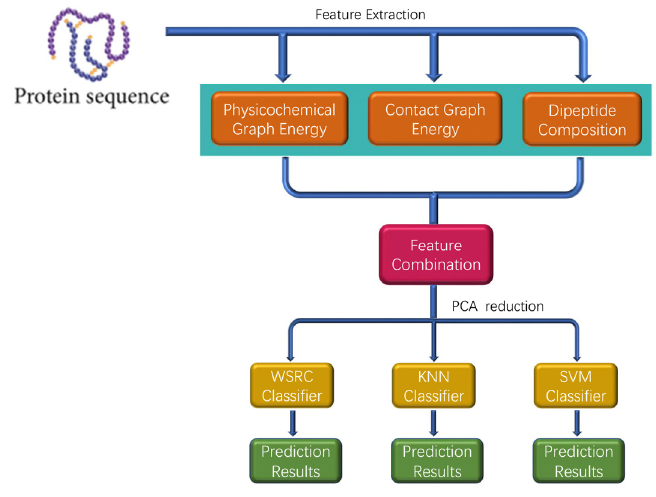
Figure 7. The flowchart of the proposed method for predicting protein-protein interactions (PPIs).